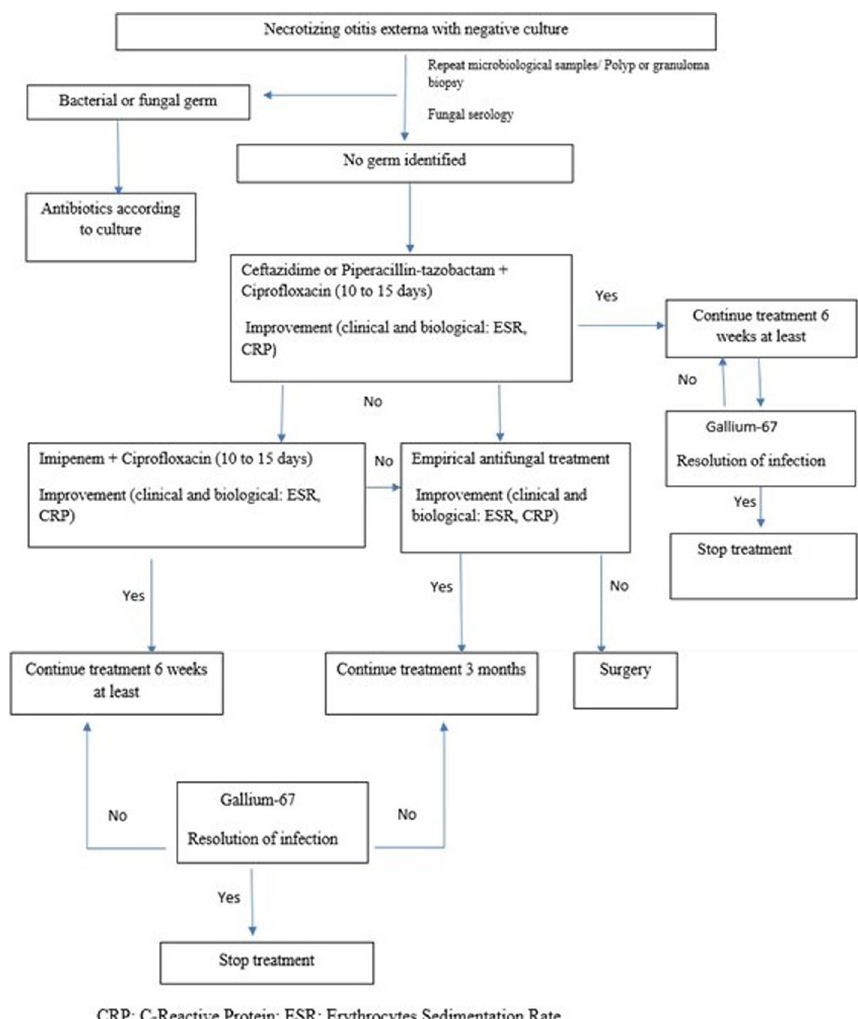
Fig. 3 Management protocol of necrotizing otitis externa with negative